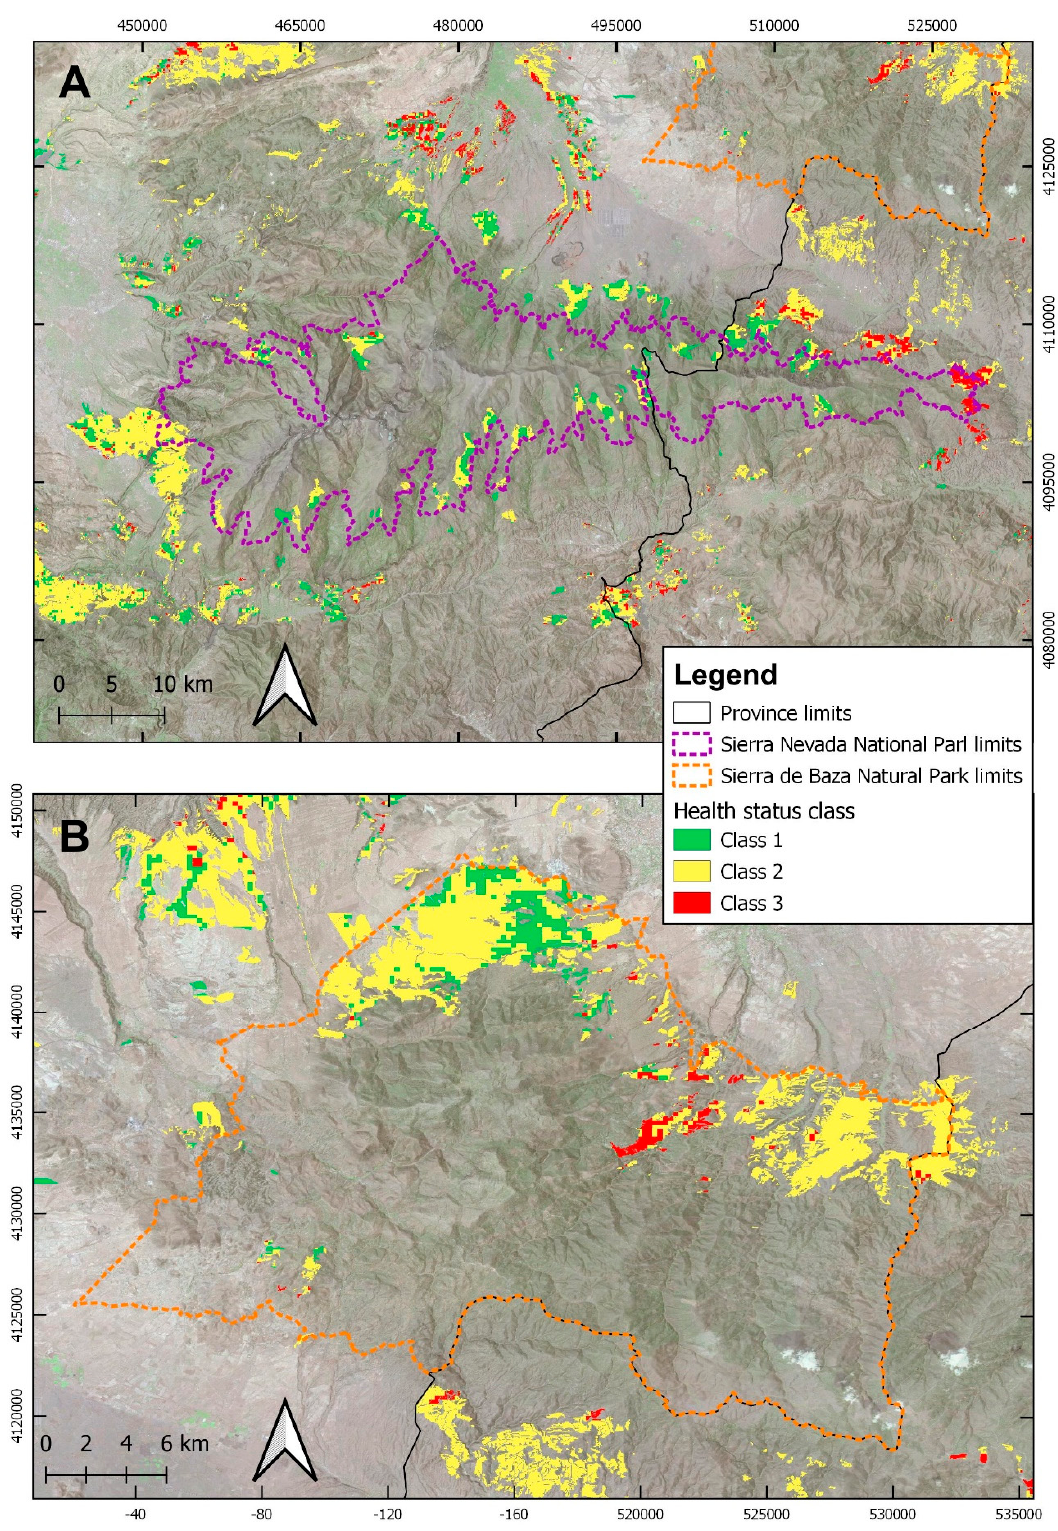
Figure 6. Defoliation status in Pinus halepensis stands a ff ected by ‘Candidatus Phytoplasma pini’ in Andalusia (south-eastern Spain) grouped in three classes according to predicted ∆ NBR ls . ( A ) Sierra Nevada National Park and ( B ) Sierra de Baza Natural Park. Class 1: Low-risk, Class 2: Middle risk and Class 3: High-risk areas.